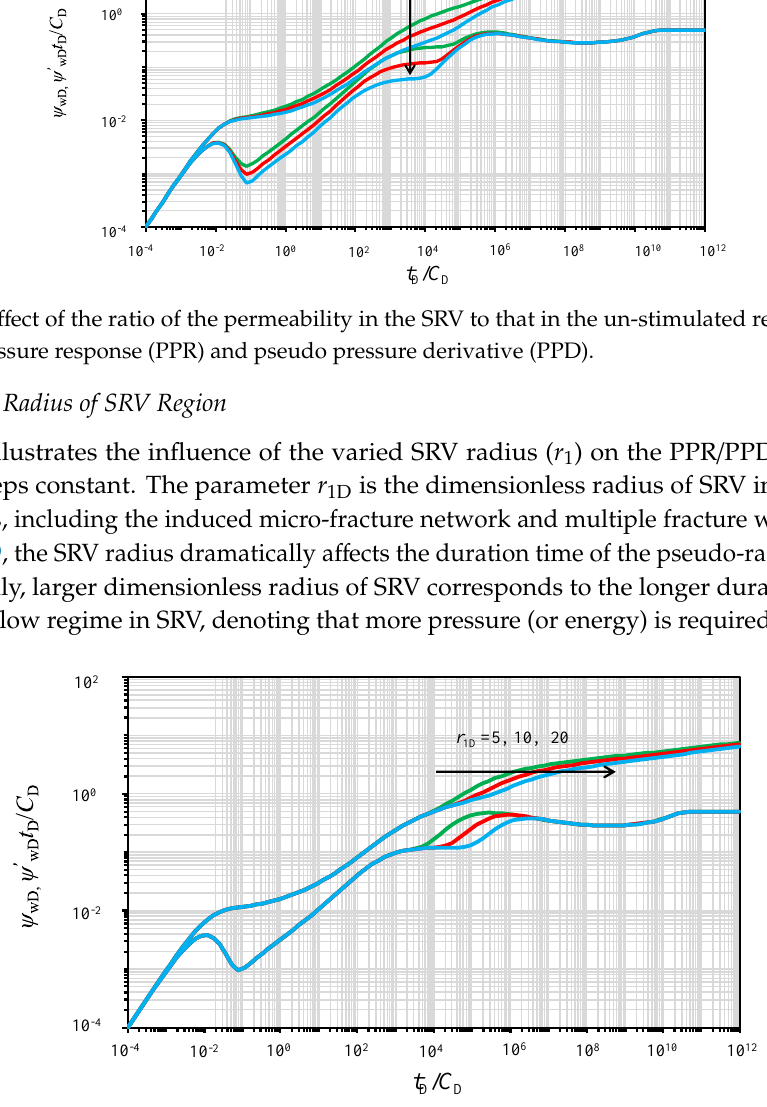
ff ect of the SRV radius on the PPR and Figure 9. Effect of the SRV radius on the PPR and PPD. Figure 9. E Figure 9. Effect of the SRV radius on the PPR and PPD.